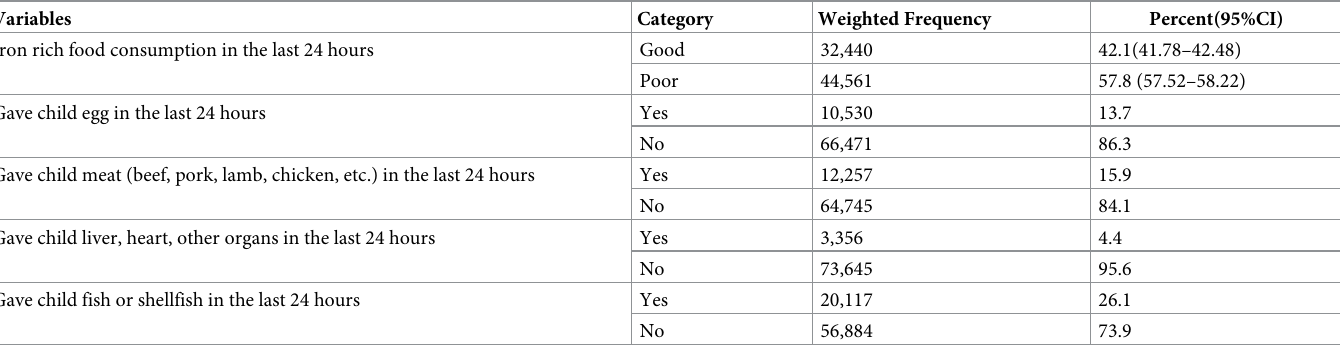
Table 3. Consumption of iron rich foods among children aged 6–23 months, sub-Saharan Africa (n =